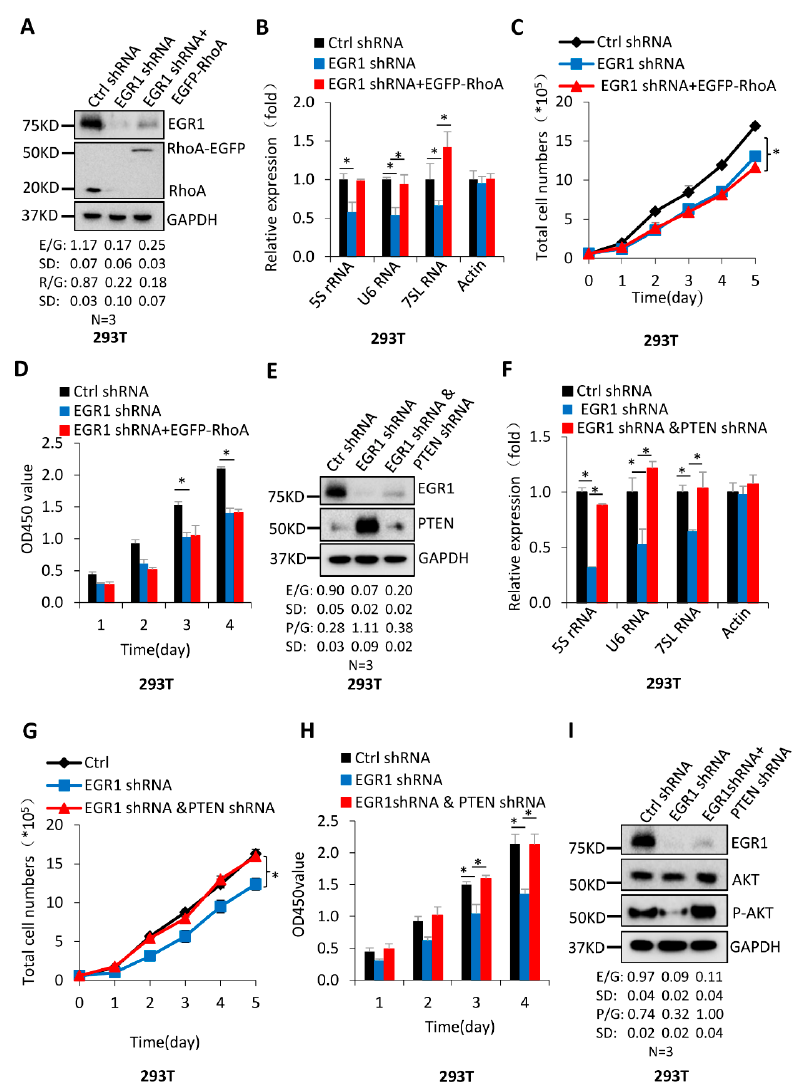
Figure 6. EGR1 regulates Pol-III-directed transcription by affecting PTEN/AKT signalling activity: (A) Western blotting was used to verify the generation of 293T cell line stably expressing both EGR1 shRNA and RhoA–EGFP; (B) RhoA–EGFP expression reversed the inhibition of U6 RNA and 7SL RNA expression caused by EGR1 downregulation. Pol III products were analysed using RT-qPCR using the cell lines generated in A; (C,D) RhoA–EGFP expression did not change the in- hibition of cell proliferation caused by EGR1 depletion. Cell counting (C) and MTT (D) assays were performed using the cell line generated in A; (E) Western blot results showing the generation of the 293T cell line stably expressing both EGR1 shRNA and PTEN shRNA; (F) PTEN silencing reversed the inhibition of Pol III products expression caused by EGR1 downregulation. Pol III products were monitored with RT-qPCR using 293T cell lines generated in E; (G,H) PTEN deple- tion alleviated the inhibition of cell proliferation caused by EGR1 downregulation. Cell counting (G) and MTT (H) assays were performed using the cell lines generated in E; (I) EGR1 expression positively correlated with AKT phosphorylation levels in 293T cells. Western blotting was per- formed using the cell lines and the antibodies against the factors, as indicated. E/G, P/G, R/G, and pA/G, respectively represent the ratio of EGR1 (E), PTEN(P), RhoA (R), and p-AKT (pA) intensi- ties to the GAPDH (G) intensity (n = 3). Each column in the point–line and bar graphs represents